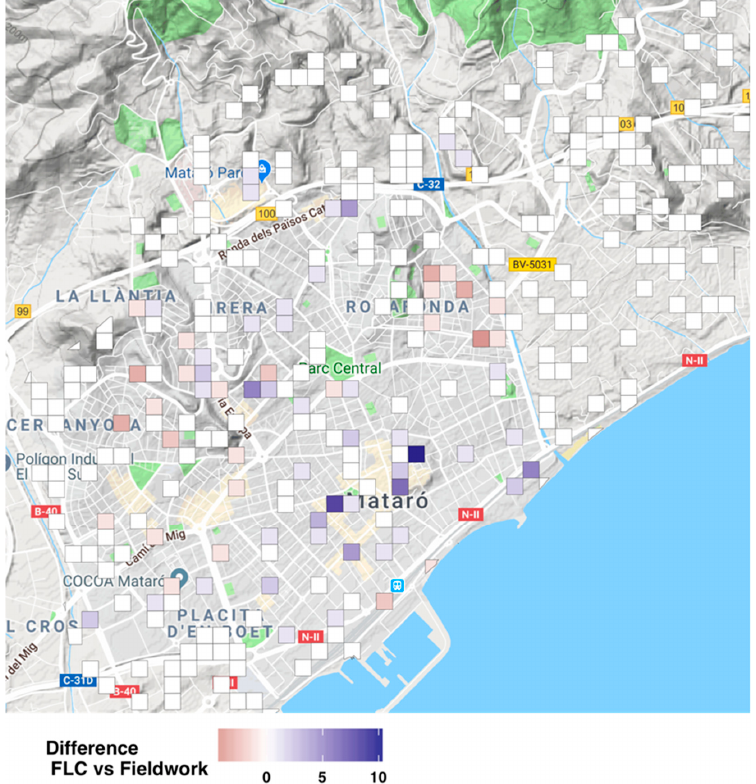
Figure 4. Spatial distribution of the difference between the FLC and the street audit (field work). The map shows the difference between facilities found using the FLC and street audit at the randomly selected grids; purple color stands for false positives (i.e., FLC larger than field work), pink color stands for false negatives (i.e., FLC smaller than field work), and white color stands for a perfect match between the two methods.